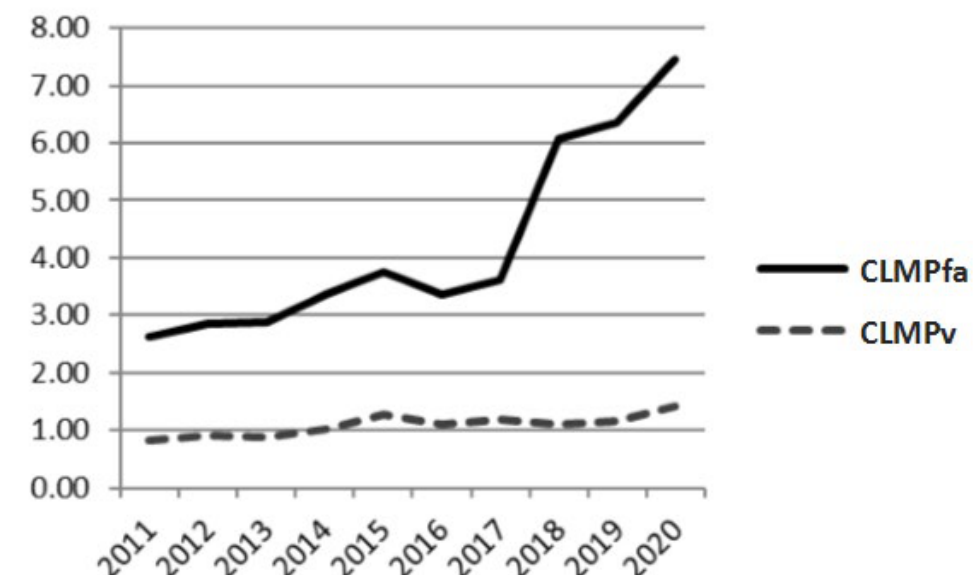
Figure 13. CLMP value dynamic for Freeport-McMoRan Inc. CLMPfa—CLMP based on the total fixed assets; CLMPv—CLMP based on the total cost of machinery and equipment.